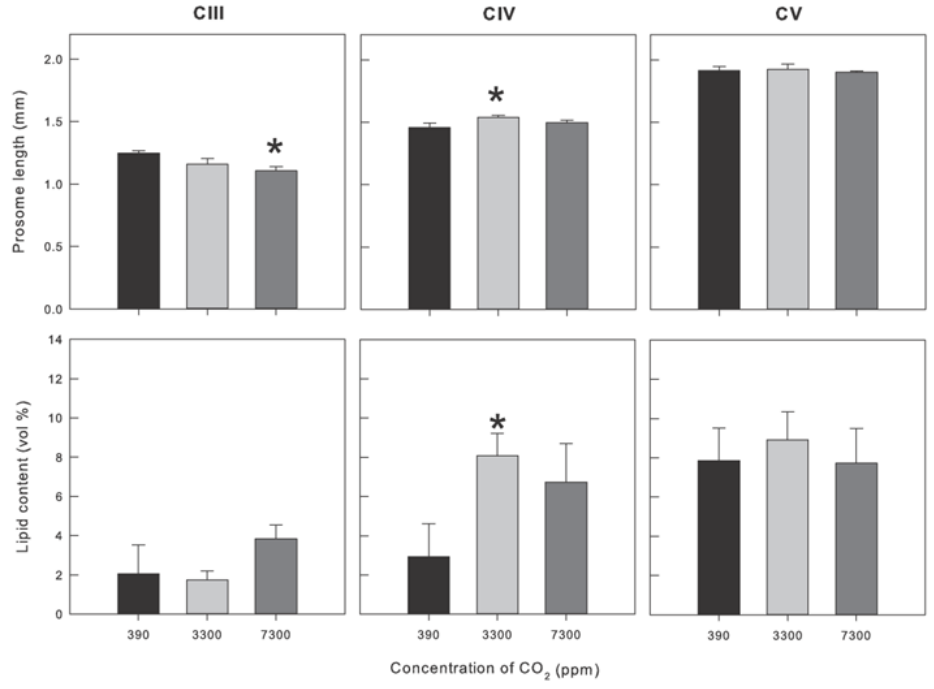
Fig. 4. Stage-specific prosome and lipid content (volume %) of the animals following 28-day exposure to different levels of CO 2 -acidified seawater. The bars indicate mean ± 1 std ( n = 3), and significant differences ( p < 0 . 05) between control and exposed groups are indicated by asterisks (*). The total number of individuals measured in the experiment was CIII = 43, CIV = 254, CV =